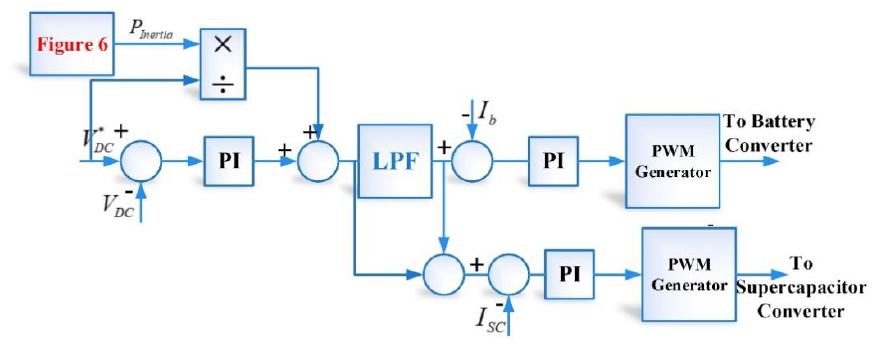
Figure 7. Hybrid energy storage system controller.